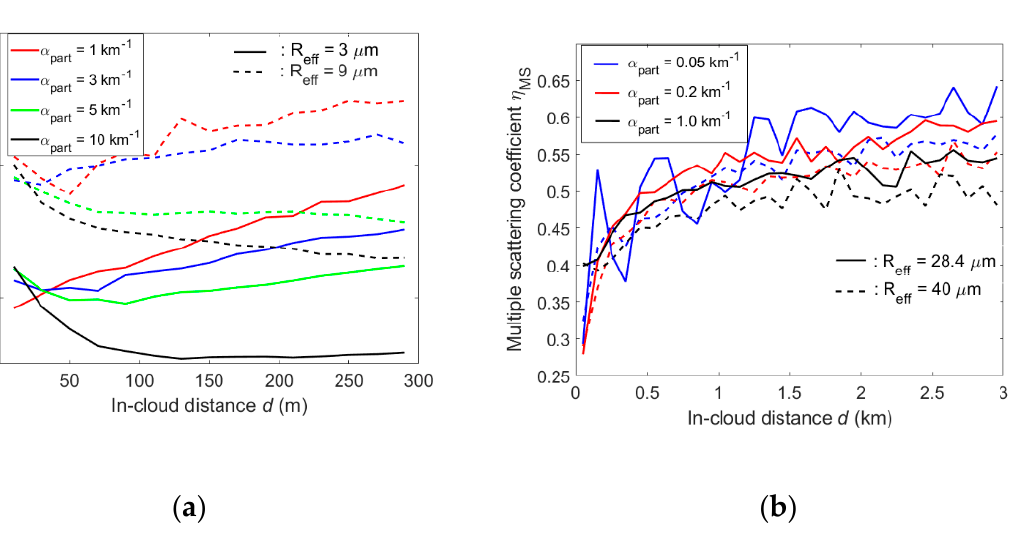
Figure 3. Multiple-scattering coefficient η MS ( d ) as a function of the in-cloud distance d from the top of clouds. ( a ) Stratocumulus cloud with R ef f = 3 µ m (full curves) and R ef f = 9 µ m (dotted curves); stratocumulus extinction is 1 km − 1 (red), 3 km − 1 (blue), 5 km − 1 (green), and 10 km − 1 (black). ( b ) Cirrus cloud with R ef f = 28.4 µ m (full curves) and R ef f = 40 µ m (dotted curves); cirrus extinction is 0.05 km − 1 (blue), 0.2 km − 1 (red), and 1.0 km − 1 (black). Table 1. Multiple-scattering coefficient η 0 used in BLISS for stratocumulus and cirrus clouds. Stratocumulus Cloud Cirrus Cloud